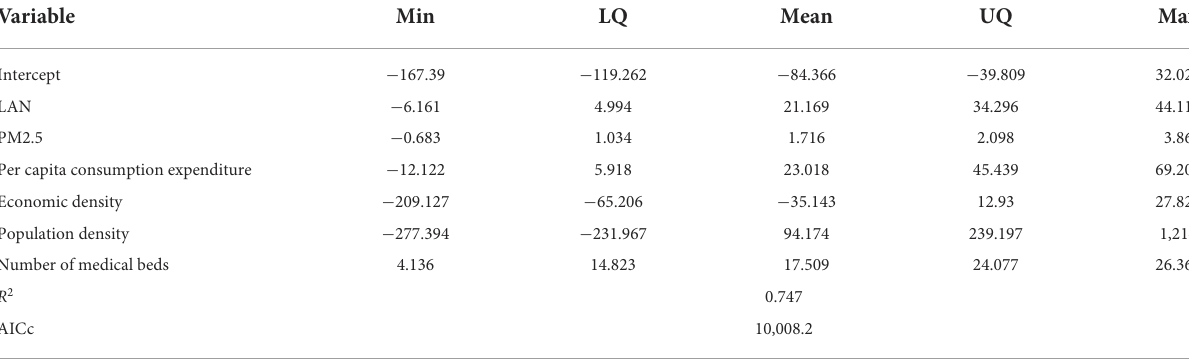
TABLE 4 Parameter estimate summaries of GTWR on the entire data set.